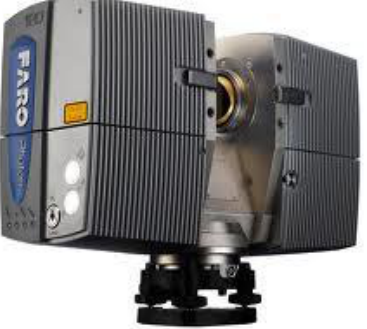
Figure 01. The laser scanner used for this survey: the Photon 120 produced by the German company FARO© Europe